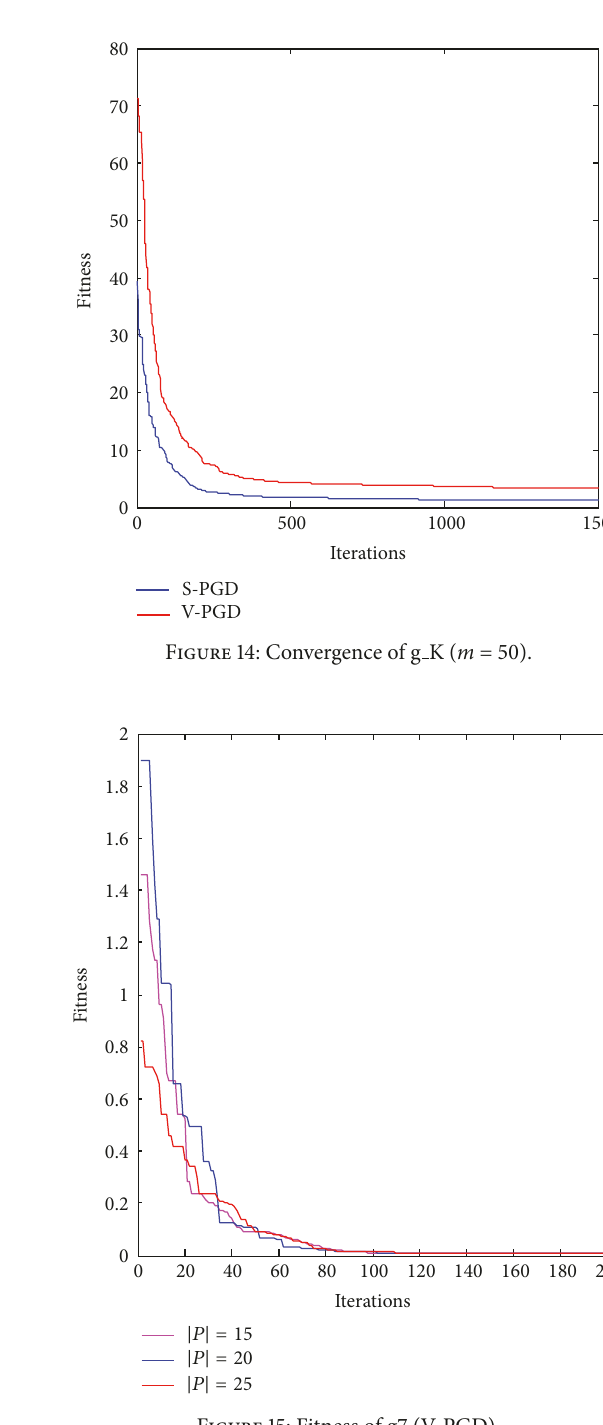
Figure 15: Fitness of g7